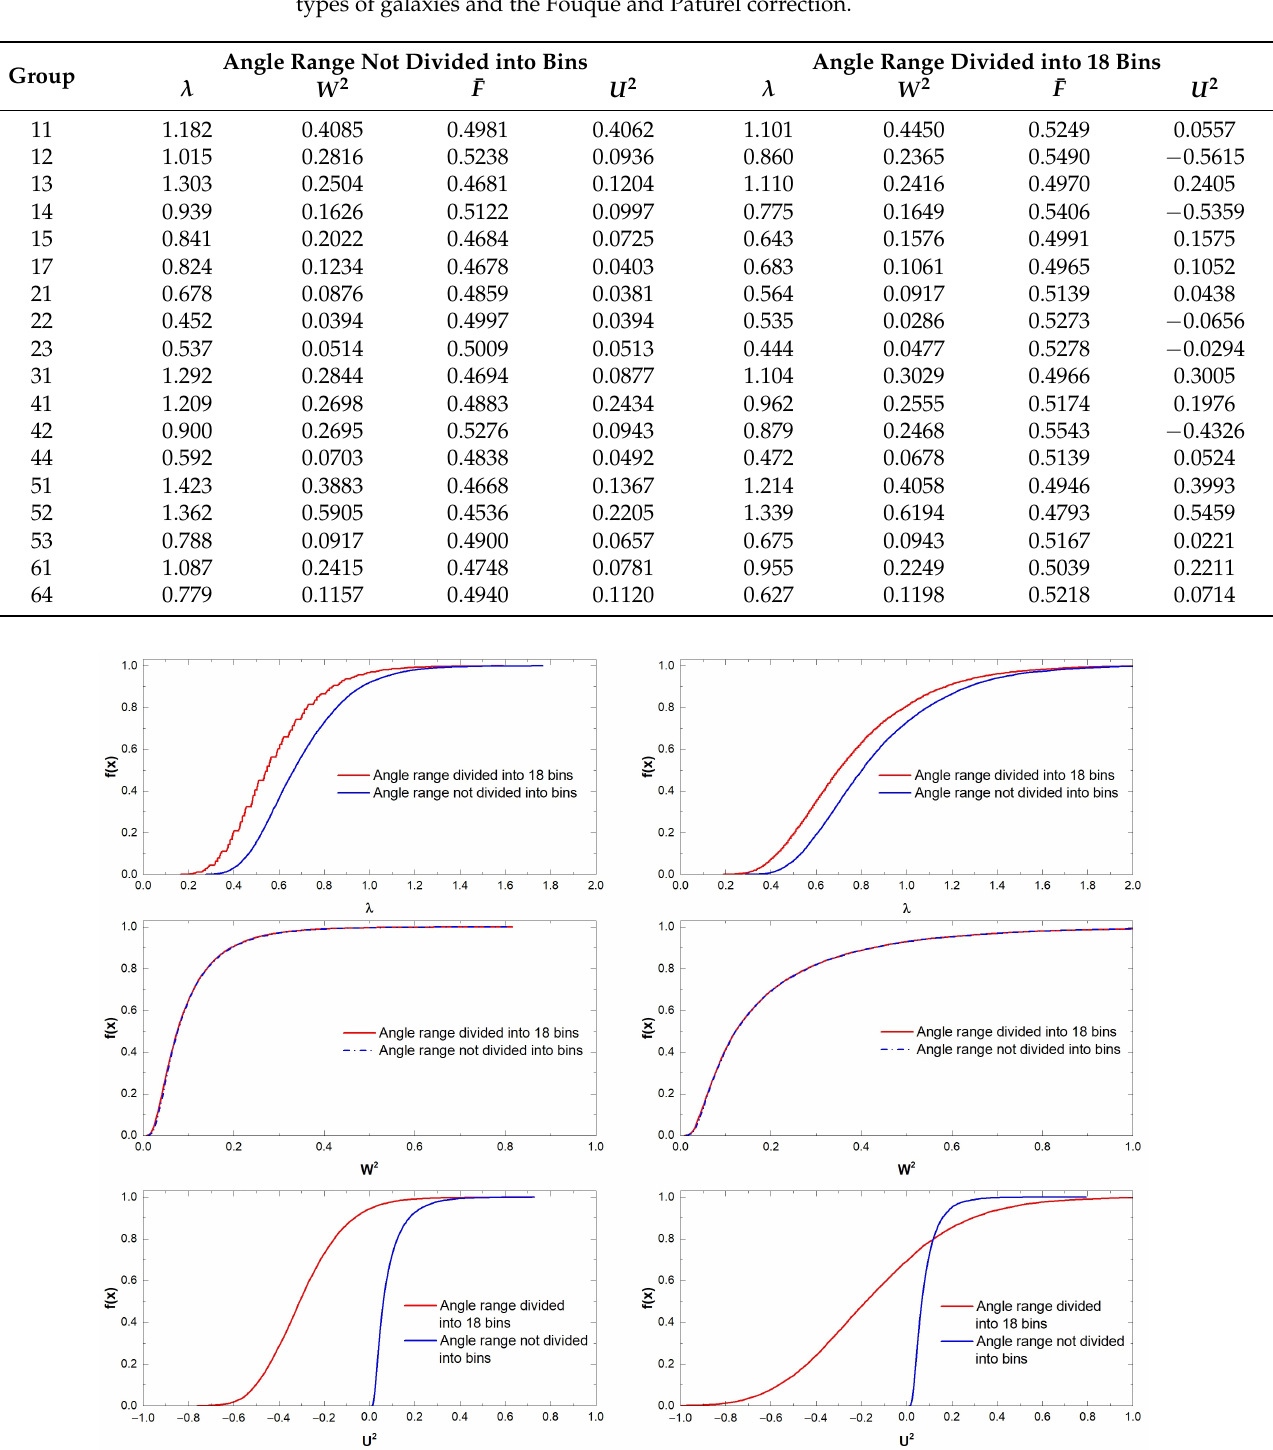
Figure A1. The Cumulative Distribution Function (CDF) of the angle δ D (left panel) and η (right panel) for analyzed statistics for group 12. Comparison of statistical tests calculated by dividing and not dividing the range of the analyzed angles into bins From up to down, we present statistics: λ , W 2 and U 2